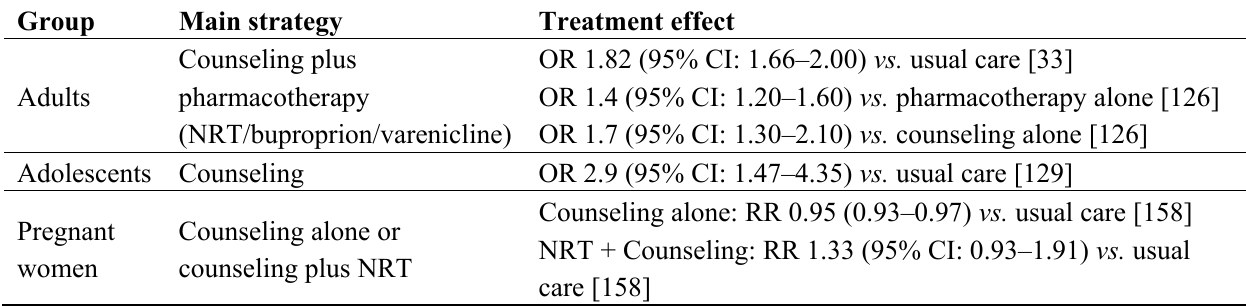
Table 5. Tobacco cessation strategies used in the general